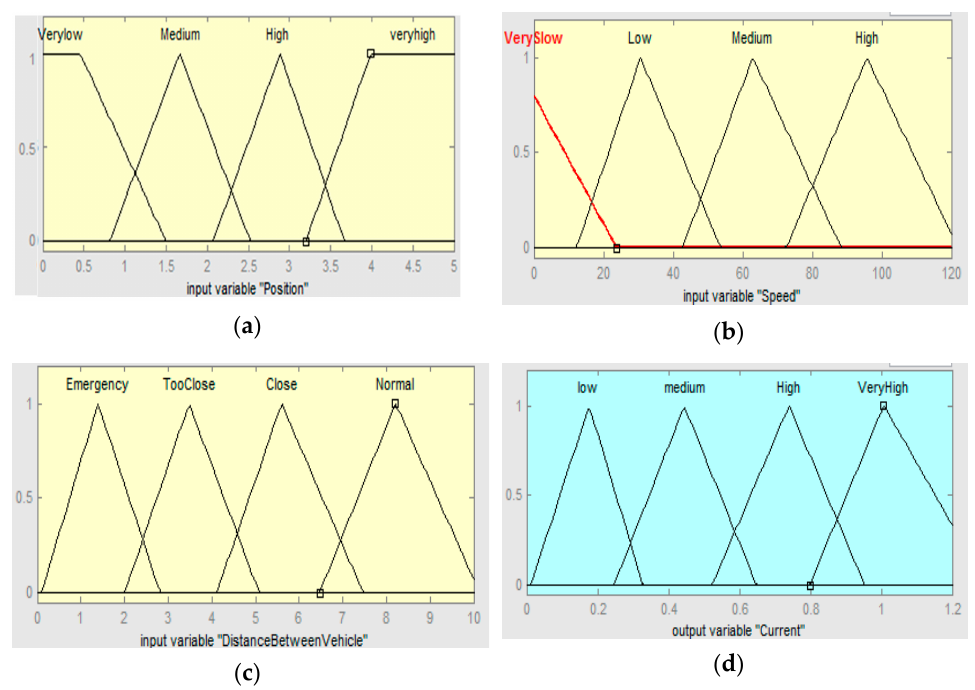
Figure 8. Membership functions of inputs and output; ( a ) pedal position, ( b ) distance between the vehicles, ( c ) speed of the vehicles, ( d ) output membership.